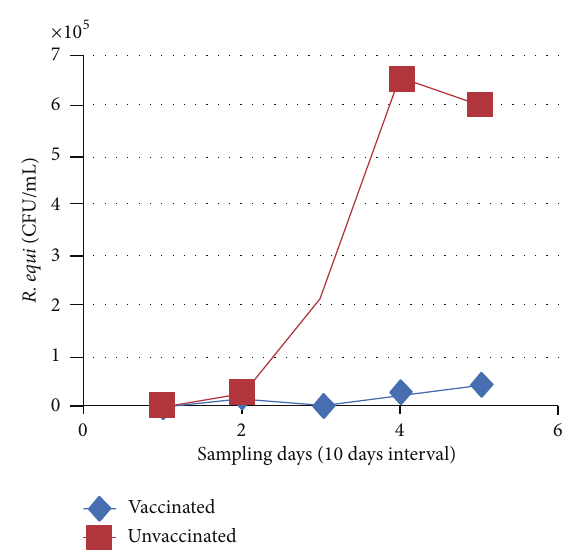
Figure 1: Reisolation rate of R. equi from foals’ BALF samples